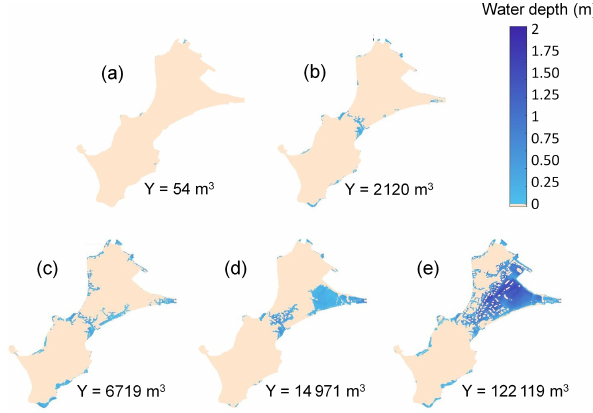
Figure 2. Examples of five maps of water depth modelled by the nu- merical simulator described in Sect. 2 using DEM 2015. The value of the flood-induced inland water volume Y is indicated for the five cases. In the study, the volume values of 50, 2000 and 15000m 3 have been selected to categorize the flooding event as minor, moder- ate and very large. Note that due to lack of numerical results with Y close to 15000m 3 in the database of simulation results (see Sect. 5), panel (d) is provided using DEM 2008